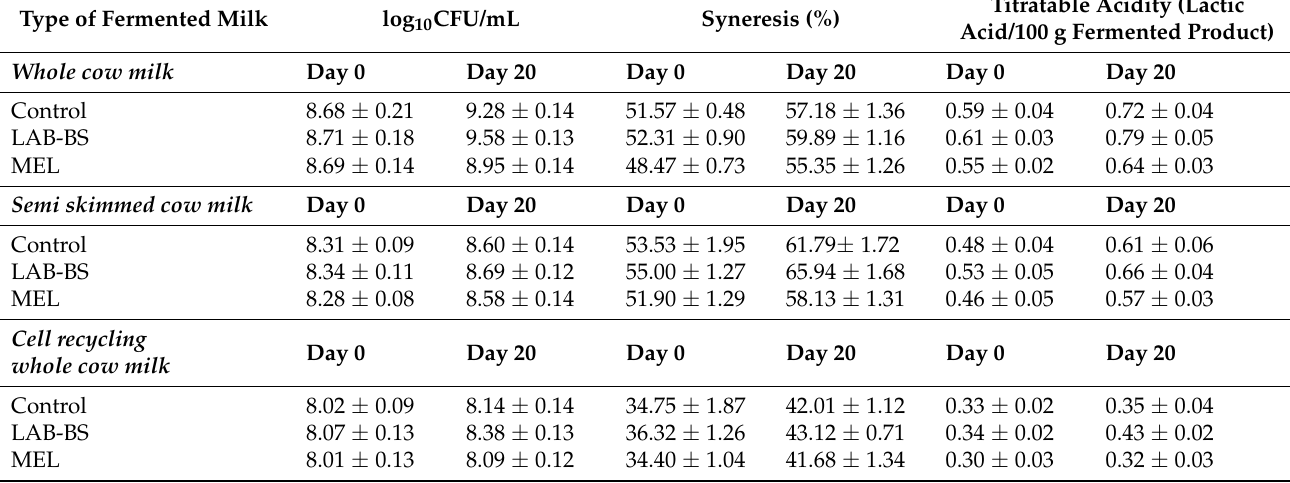
Table 4. Microbiological and physicochemical changes during cold storage of fermented milk prepared using the strain L. fermentum ACA-DC 0182 on whole and semi skimmed cow milk, and cell recycling fermented milk, with and without the addition of lactobacilli and Moesziomyces